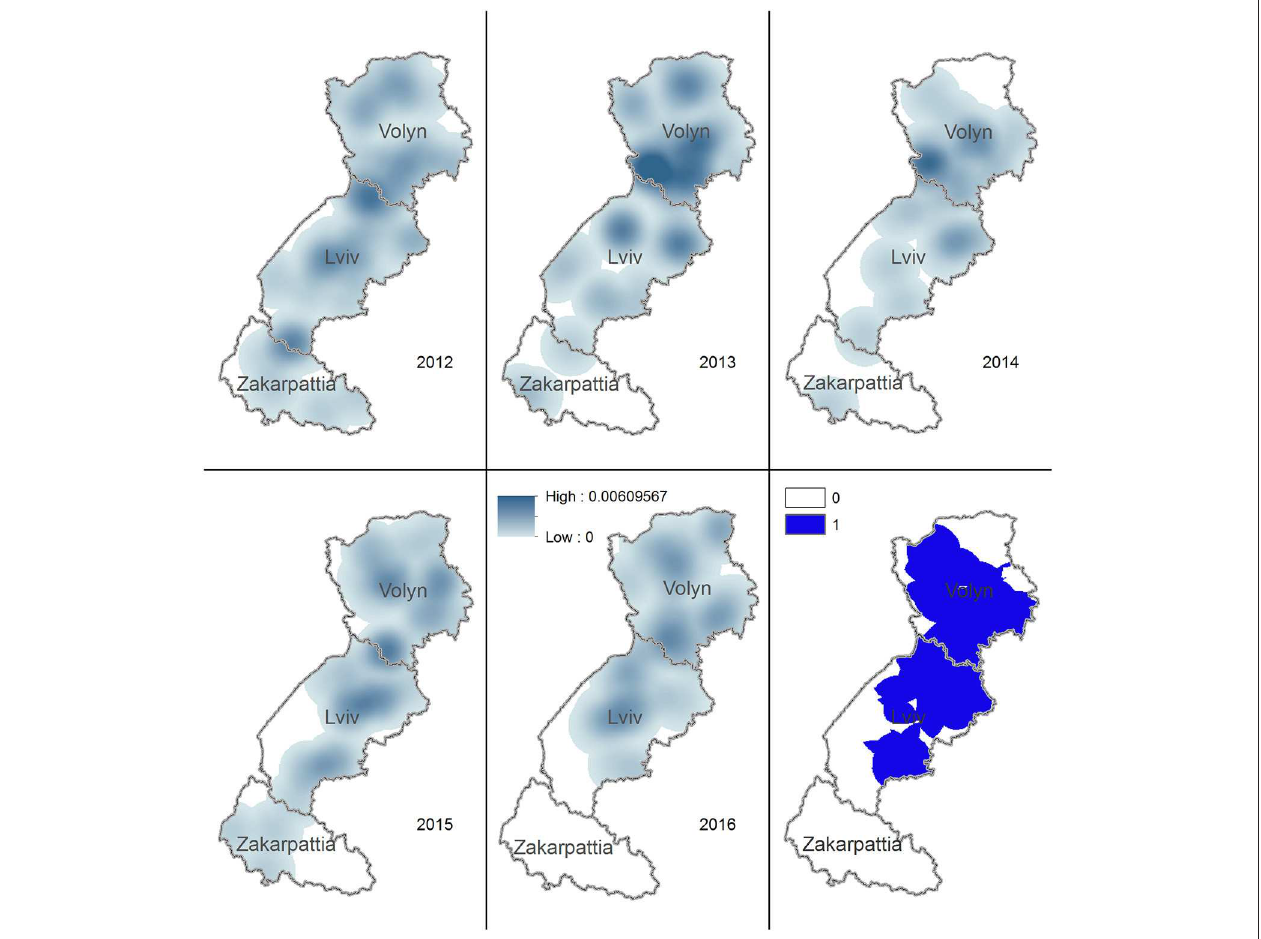
FIGURE 4 | Kernel density estimation of rabies cases in foxes in Volyn, Lviv, and Zakarpattia oblasts. Yearly maps representing the areas with higher density of rabies cases in foxes for years 2012–2016 are shown. Solid blue color on the bottom right figure marks the territory where the density of cases is consistently > 0 across all